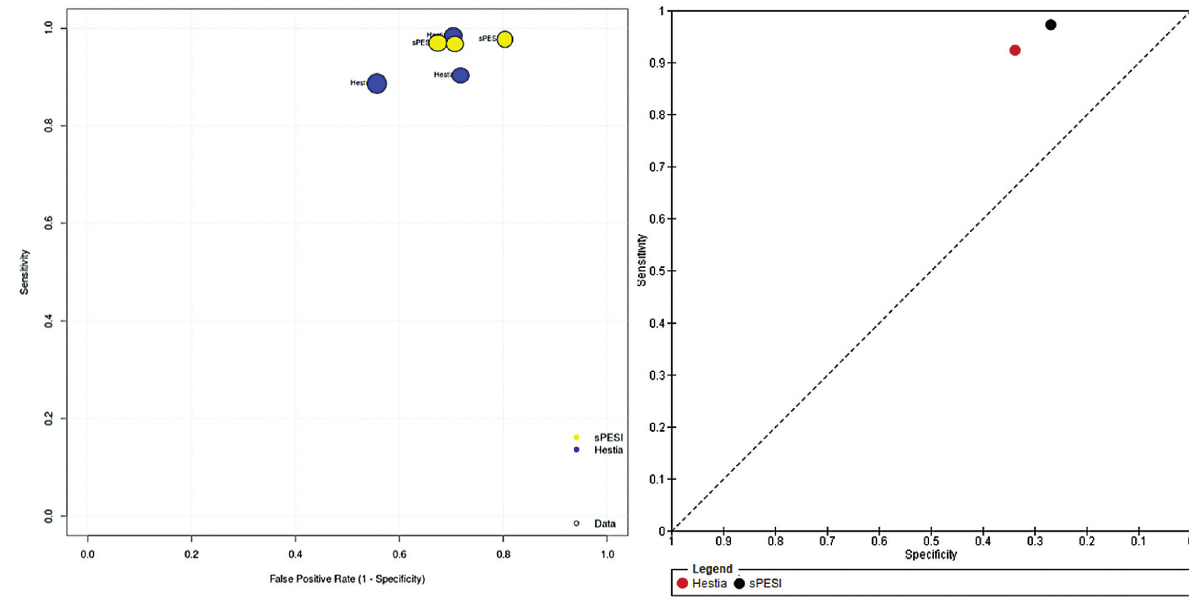
Fig. 3 Estimates of individual studies (left) and pooled data (right) in Receiver-Operating Characteristic Curve, comparing Hestia Criteria and sPESI score. sPESI: simpli fi ed Pulmonary Embolism Severity Index.